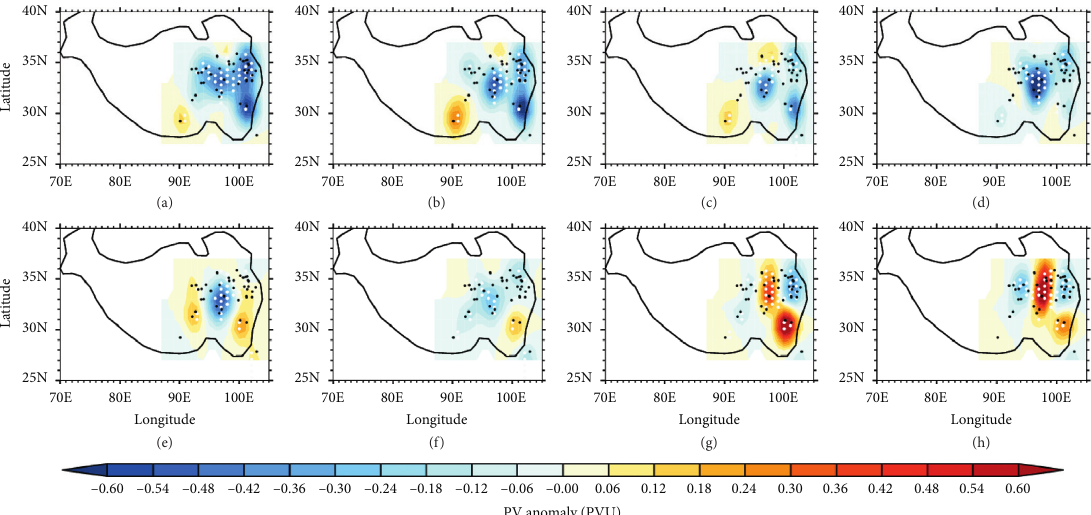
Figure 4: The composite horizontal distributions of anomalous PV (units: PVU) on 350K isentropic surface for the (a) 7th day, (b) 6th day, (c) 5th day, (d) 4th day, (e) 3rd day, (f) 2nd day, (g) 1st day, and (h) 0 day before the OCS onset for 41 OCS events. The white dotted areas indicate that the anomalies are statistically significant at a 95% confidence level (based on a two-sided Student’s t -test). The black dots indicate the locations of the 41 OCS